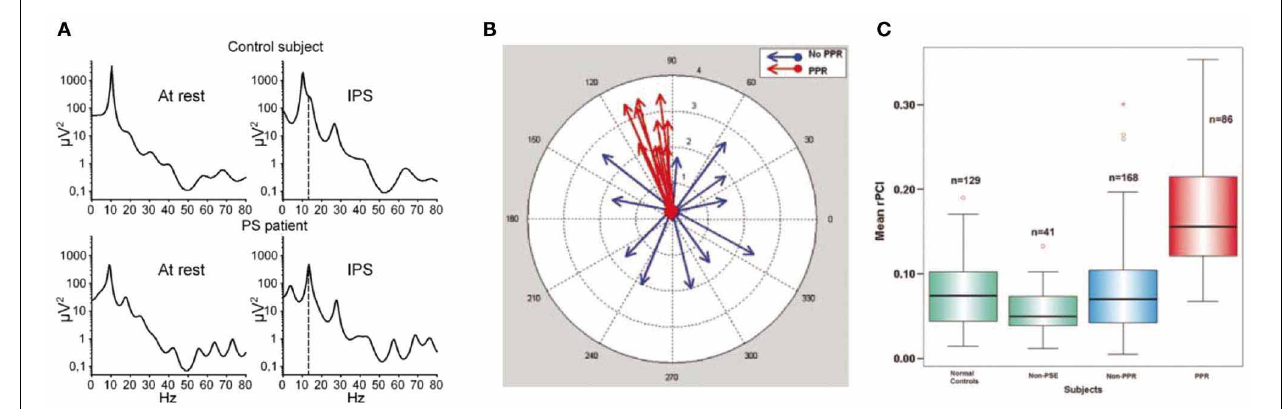
FIGURE 5 | Abnormalities of the gamma response to intermittent photic stimulation (IPS) in photosensitive epilepsy (PS). (A) Logarithmic power spectra of local field potential in occipital EEG electrodes at rest (left) and during intermittent photic stimulation at 14Hz (IPS; right), in a healthy control (upper) and a photosensitive epilepsy patient (lower). In the IPS condition, the stimulation frequency (14Hz) is indicated by the dashed line. Note the resting-state power spectrum (left) shows more distinct peaks, mainly in the gamma range, in the PS patient (lower) than in the healthy control (upper); also that during IPS (right) the PS patient shows clear peaks at harmonics of the stimulation frequency, again mainly in the gamma range, indicating excessive entrainment of ongoing oscillatory brain rhythms to extrinsic stimulation in PS (reproduced with copyright-holder’s permission from Visani et al., 2010). (B) Illustration of the concept of the Phase Clustering Index (PCI)